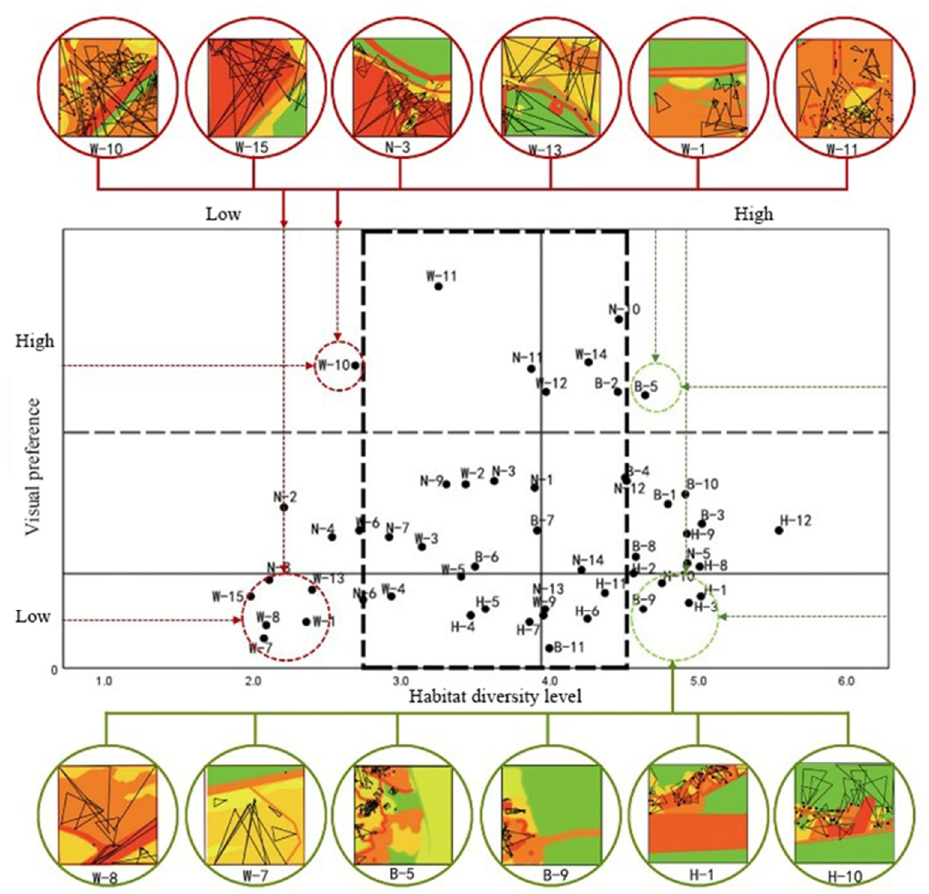
Figure 6. Analysis of views of 4 urban wetland parks.